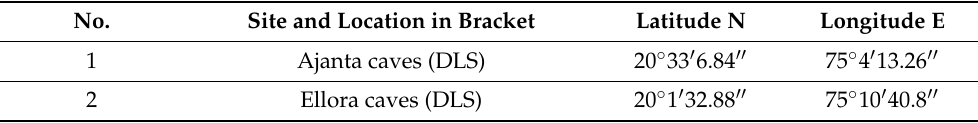
Table 2 . Locations of LS ‐ prone sites in the Nashik subregion. The words windward, ILS and DLS indicate the locations of LS sites on the windward, immediate leeward and distant leeward sites, of the WG mountains, respectively.